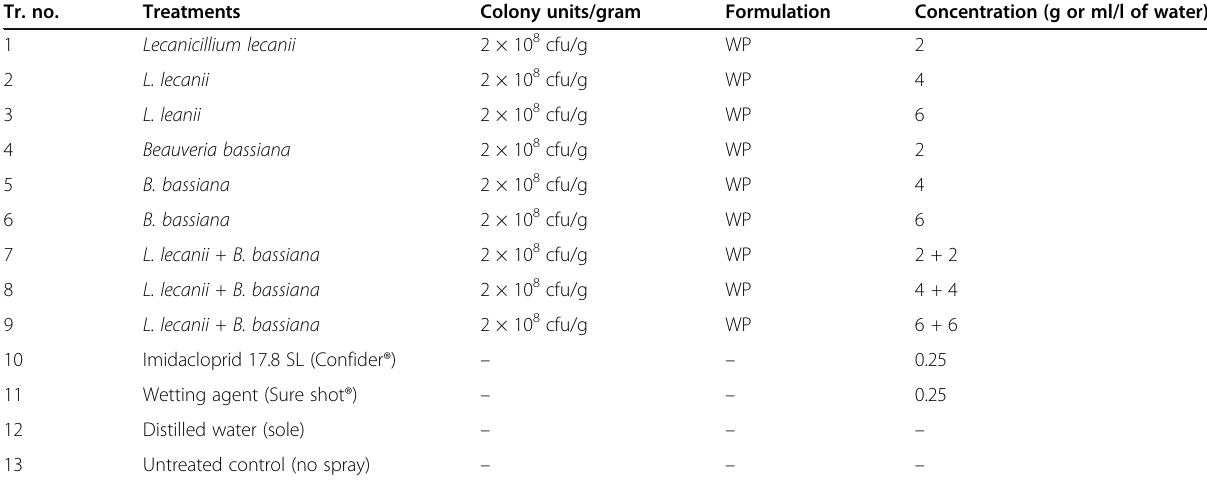
Table 1 Treatment details for the efficacy of entomopathogenic fungi against Maconellicoccus hirsutus Tr. no. Treatments Colony units/gram